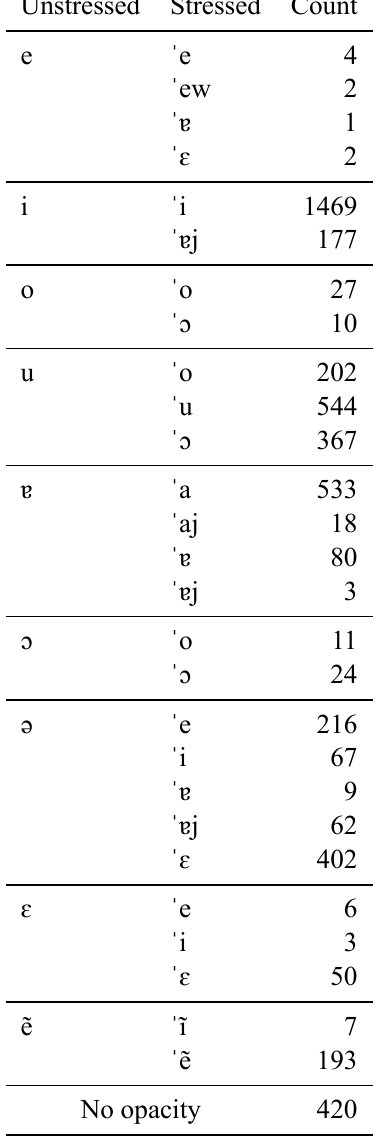
Table 21: Prediction of stressed from unstressed prethematic